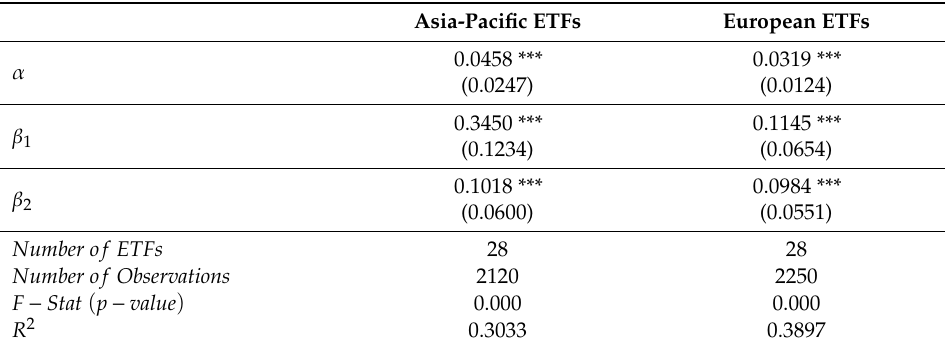
Table 7. Persistence of pricing ine ffi ciency in international